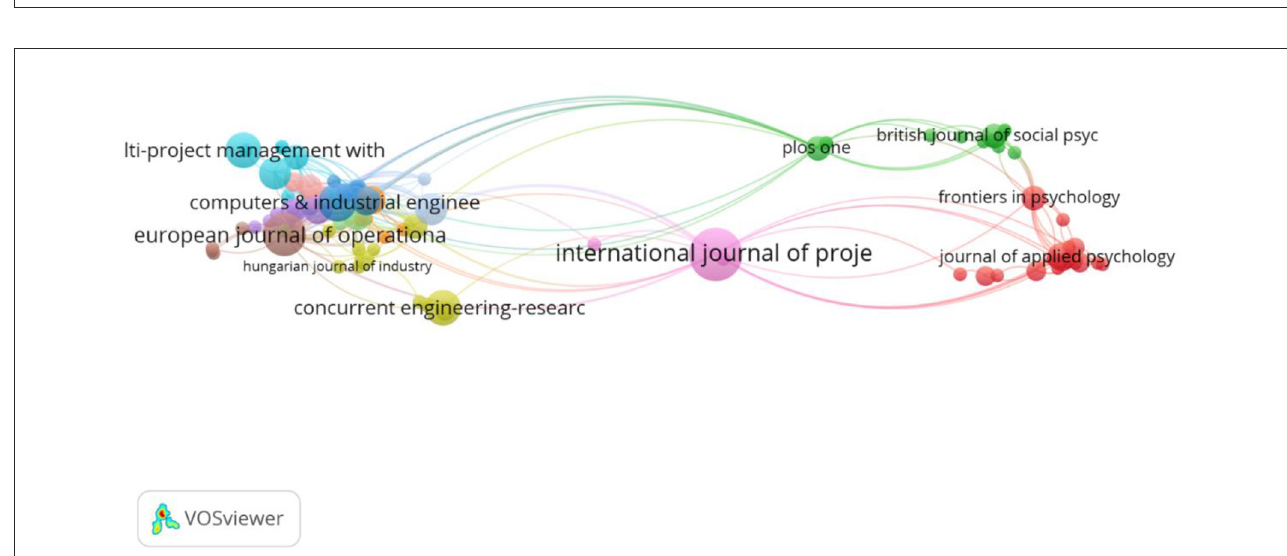
FIGURE2 Citation analysis based on 98